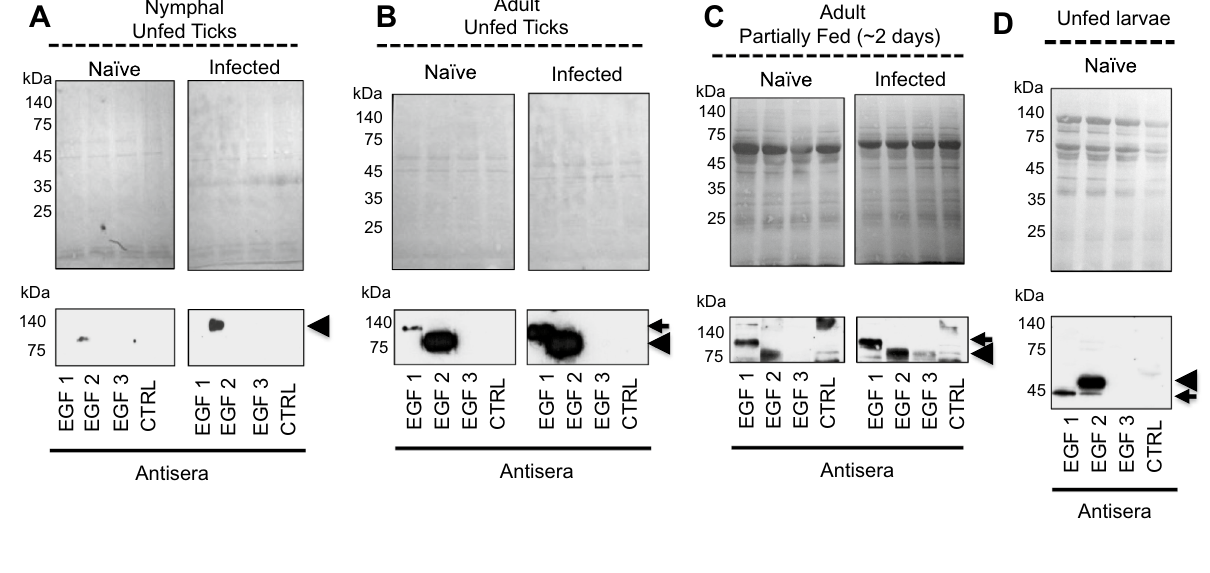
Figure 3. Expression of Is86 homologs in various tick stages. Nymphs were allowed to feed on naïve or infected mice and collected after 48 h of feeding. The naïve and infected adult ticks fed on an artificial feeding system and were collected after 48 h of feeding. The unfed nymphal ticks ( A ), as well as the dissected guts from ( B ) unfed adult ticks, ( C ) partially-fed (two-day) adult ticks, and ( D ) unfed larval ticks, were processed using SDS-PAGE, transferred to nitrocellulose membrane, stained with Ponceau S to show an equal protein loading (upper panel), and probed with antiserum against each Is86 EGF domain (EGF-1, -2, or -3). PBS and adjuvant-immunized sera were used as controls (CTRL). Arrows indicate the specific antibody response to Is86-1, and arrowheads indicate the specific response to Is86-2. For an image of the full-length immunoblot, please refer to Fig.